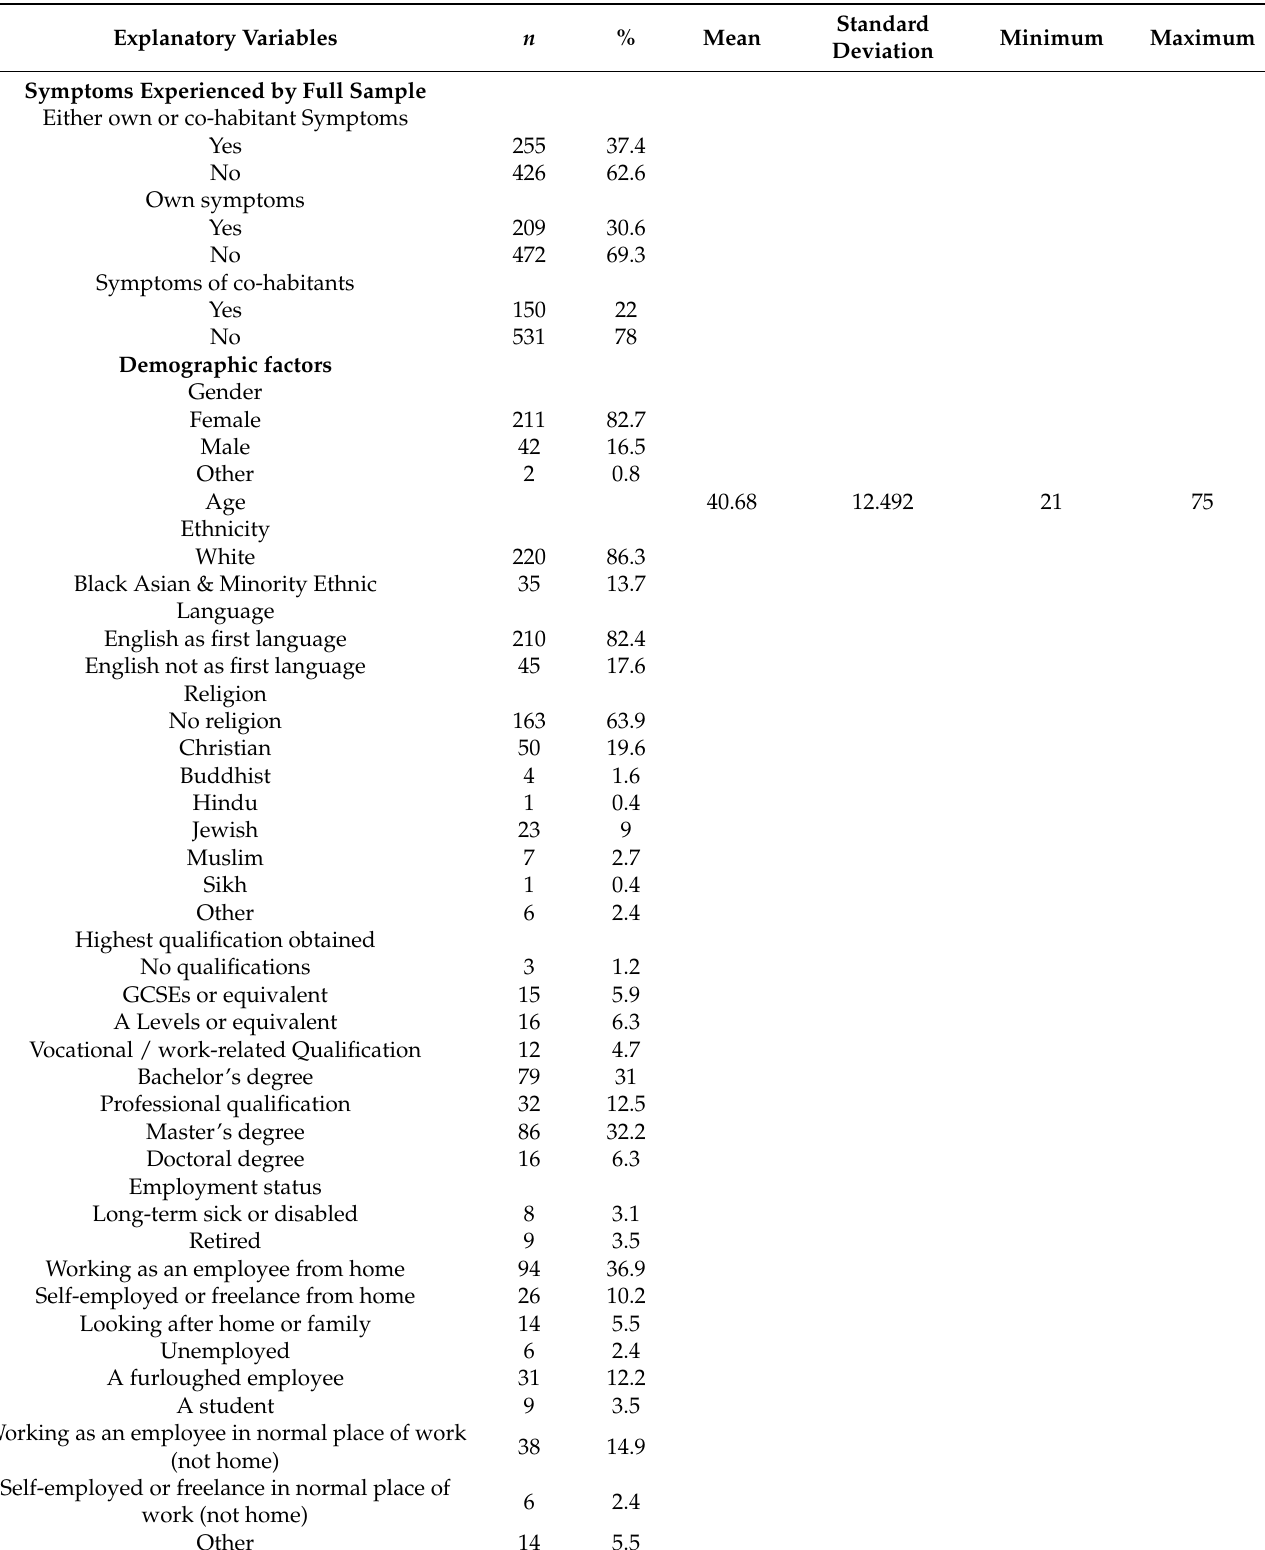
Table 2. Characteristics of